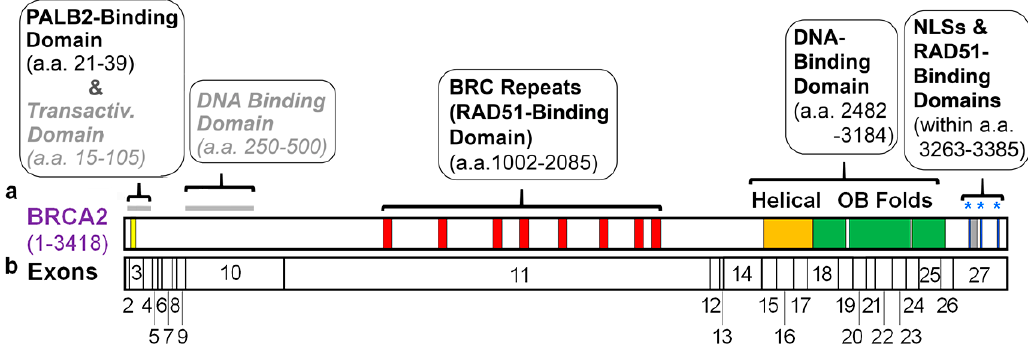
Figure 1. Diagram of the positions of identified domains in human BRCA2 and of the 27 exons that encode this protein. ( a ) At the extreme N-terminus of BRCA2 is a PALB2-binding domain (yellow bar) from a.a. 21 to 39 [38]. The central region of BRCA2 contains a RAD51-binding domain from a.a. 1002 to 2085, including 8 BRC repeats (red bars, BRC1: a.a. 1002–1036, BRC2: a.a. 1212–1246, BRC3: a.a. 1421–1455, BRC4: a.a. 1517–1551, BRC5: a.a. 1664–1698, BRC6: a.a. 1837–1871, BRC7: domain (DBD) at the C-terminus of BRCA2 (C-DBD), spanning a.a. 2482– 2668, orange bar) and three OB folds (OB1: a.a. 2670–2803, OB2: a.a. 2808–3049, and OB3: a.a. 3055–3184, each shown as a green bar) [41]. There is an additional RAD51-binding domain at the extreme C-terminus of BRCA2 (a.a. 3270–3305, grey bar) [42]. On either side of this motif are three putative nuclear localization signals (NLS) (NLS1: a.a. 3263–3269, NLS2: a.a.